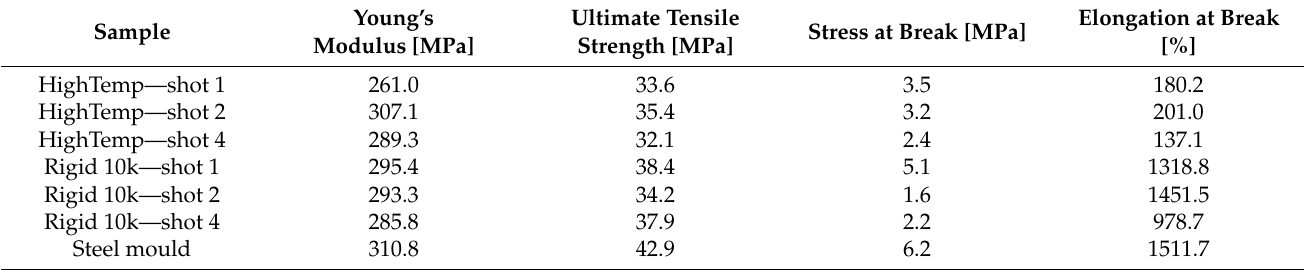
Figure 10. Selected stress-strain curves obtained for PP specimens moulded using different tool inserts. Table 4. Tensile mechanical properties of PP samples moulded using different tool inserts.